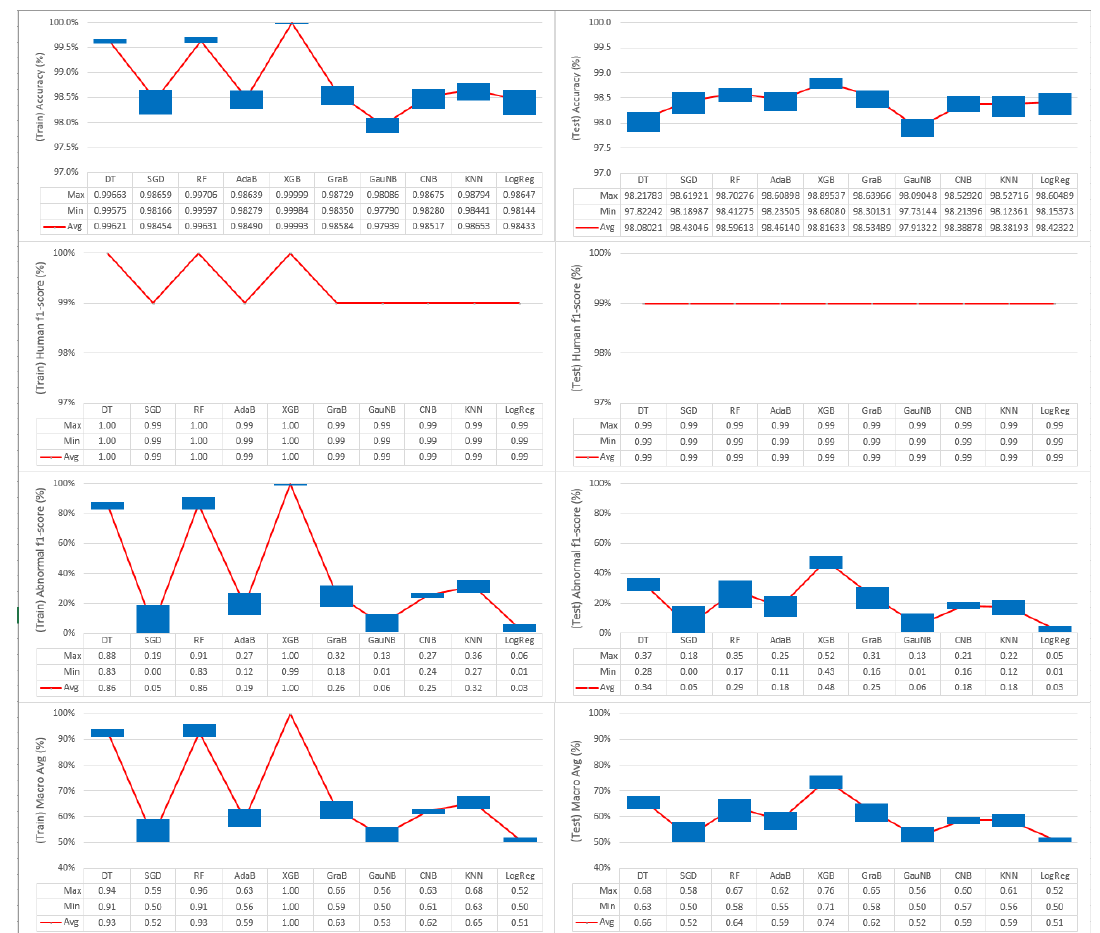
Figure 14. Accuracy and F1-score comparison of classification